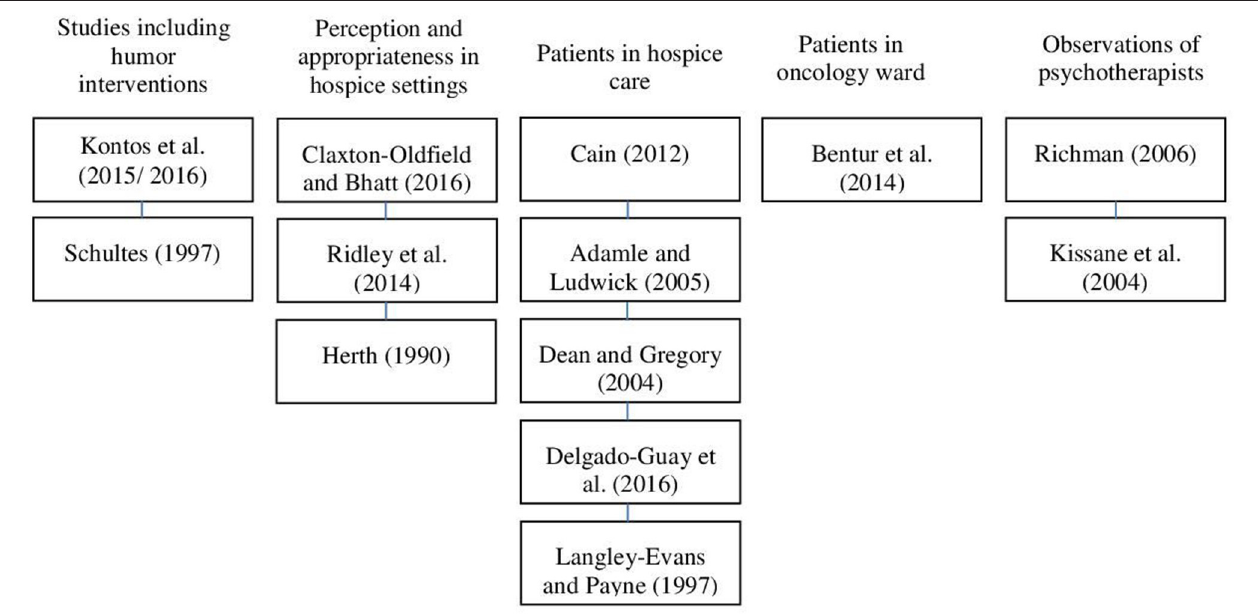
FIGURE 2 | Flowchart of included